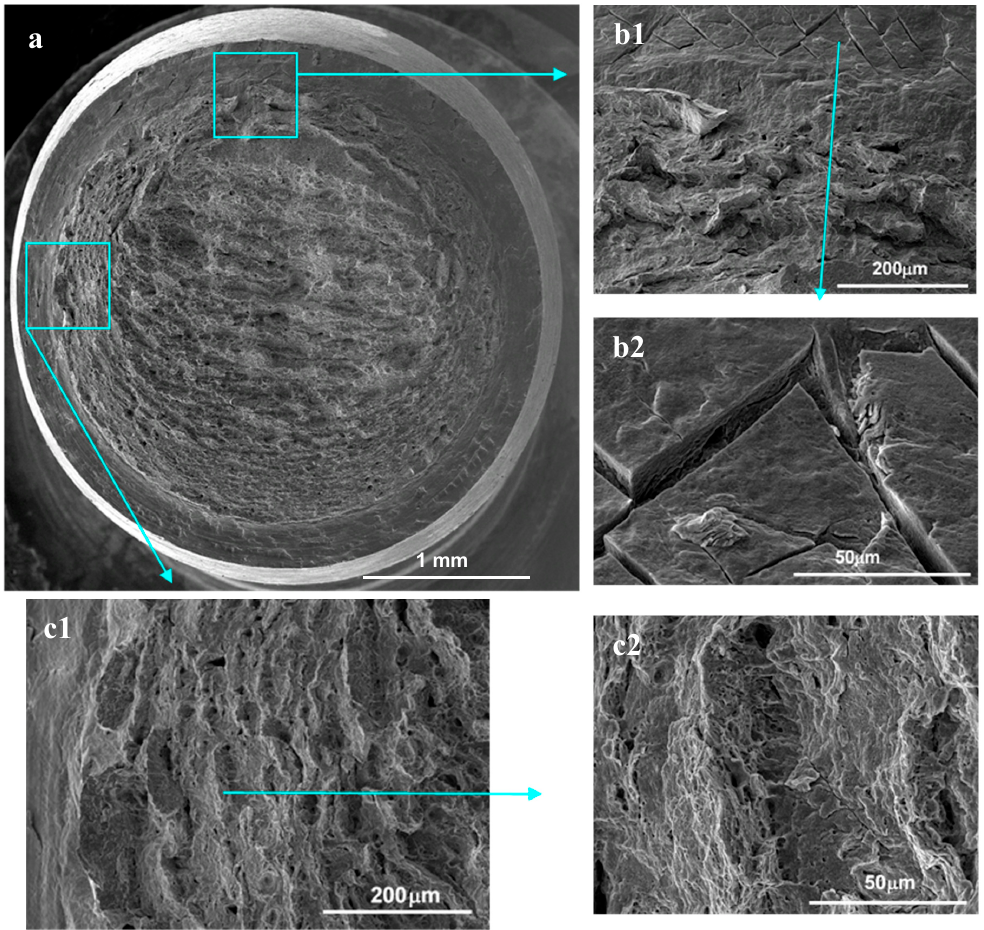
Figure 4. Fracture surface of the notched specimen (B93) tested in lead at 450 °C, R1 (2 × 10 − 6 m/s): ( a ) General view; ( b1 ) crack initiation from the notch root with ( b2 ) detail of micro cracks initiated on slip lines; ( c1 ) another crack-initiation site with ( c2 ) detail of characteristic shear patterns.